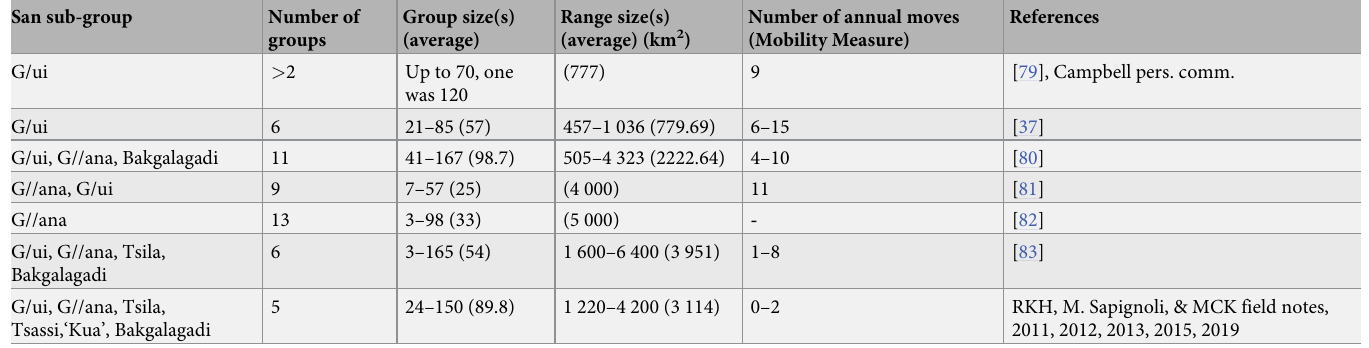
Table 3. Estimated group and range sizes, and mobility of Central Kalahari Game Reserve (CKGR) populations in Botswana, 1958–2019. All are San groups, except for the Baboalongwe Bakgalagadi (Bakgalagadi). San